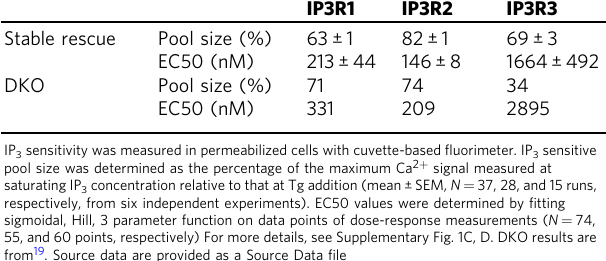
Table 1 Functional comparison of endogenous IP3R levels to those in stable-rescued cells